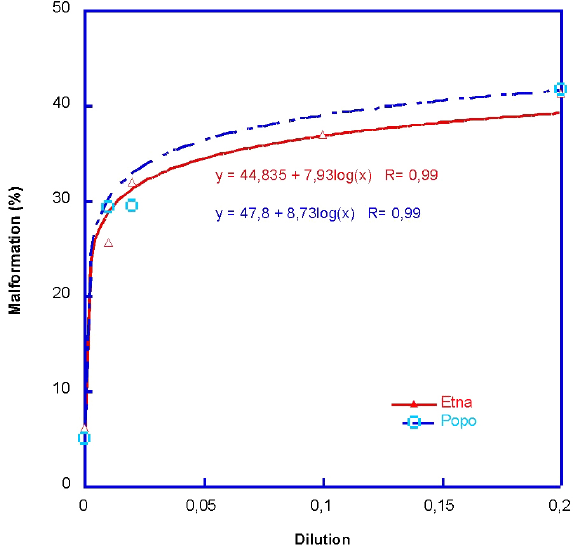
Figure 13. Malformation of embryos vs. dilution of ash leachates from Etna 2012 and